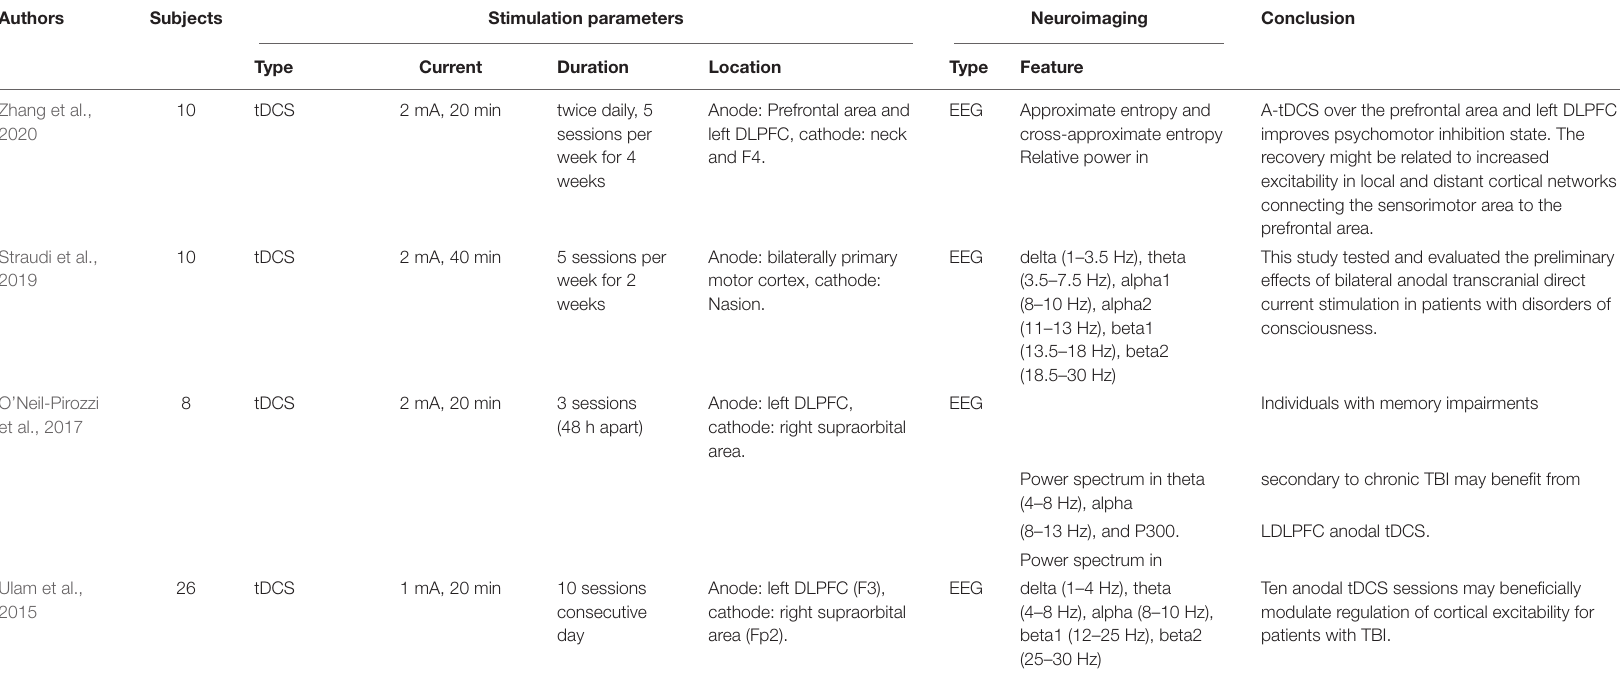
TABLE 9 | Studies and experimental characteristics of tES literature for TBI.